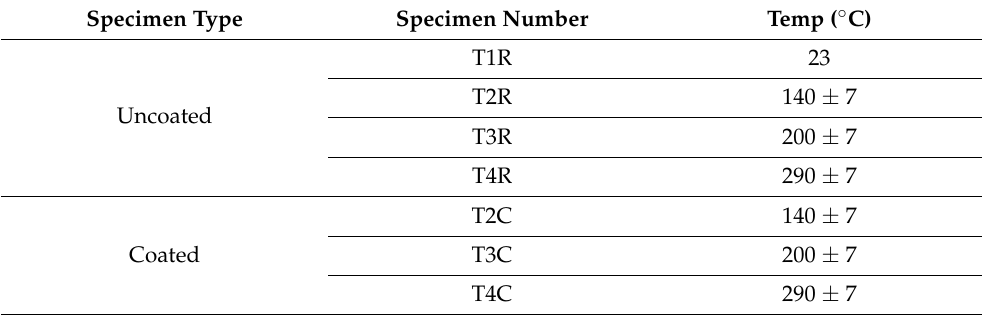
Table 2. Specimen